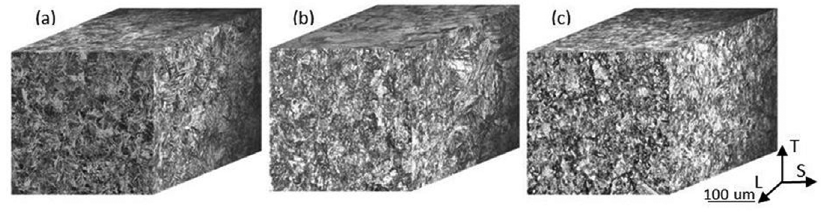
Figure 6: OM image of Ti-7Cu alloy with different forging ratios (a) 45%, (b) 60%, and (c) 75% (forging temperature 1,050 ℃ ).